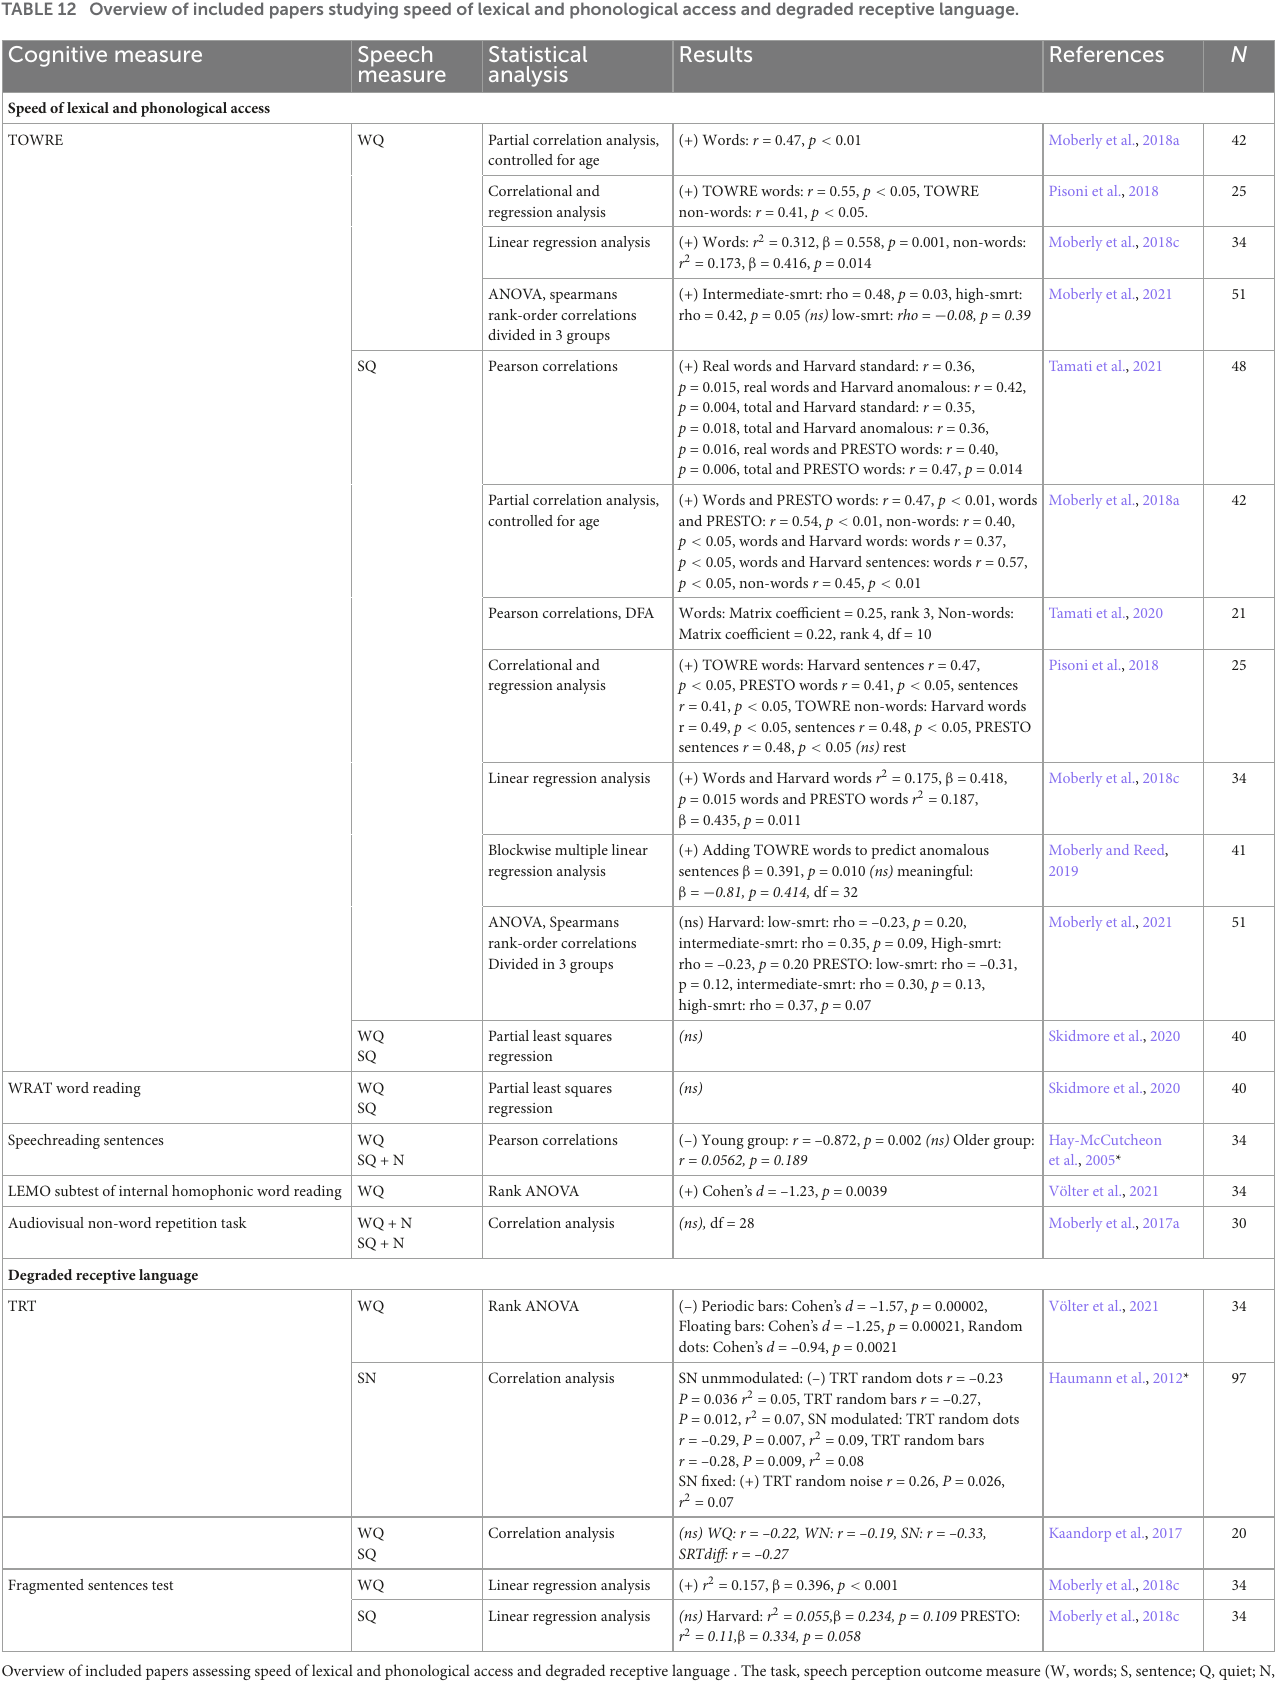
TABLE 12 Overview of included papers studying speed of lexical and phonological access and degraded receptive language.